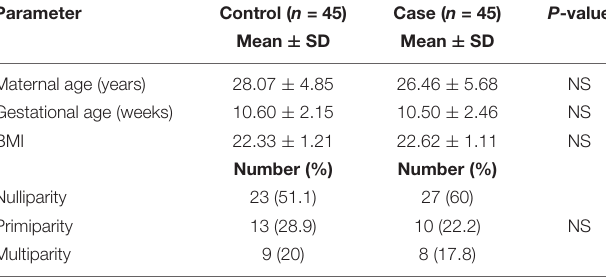
TABLE 1 | Sociodemographic characteristics among the two